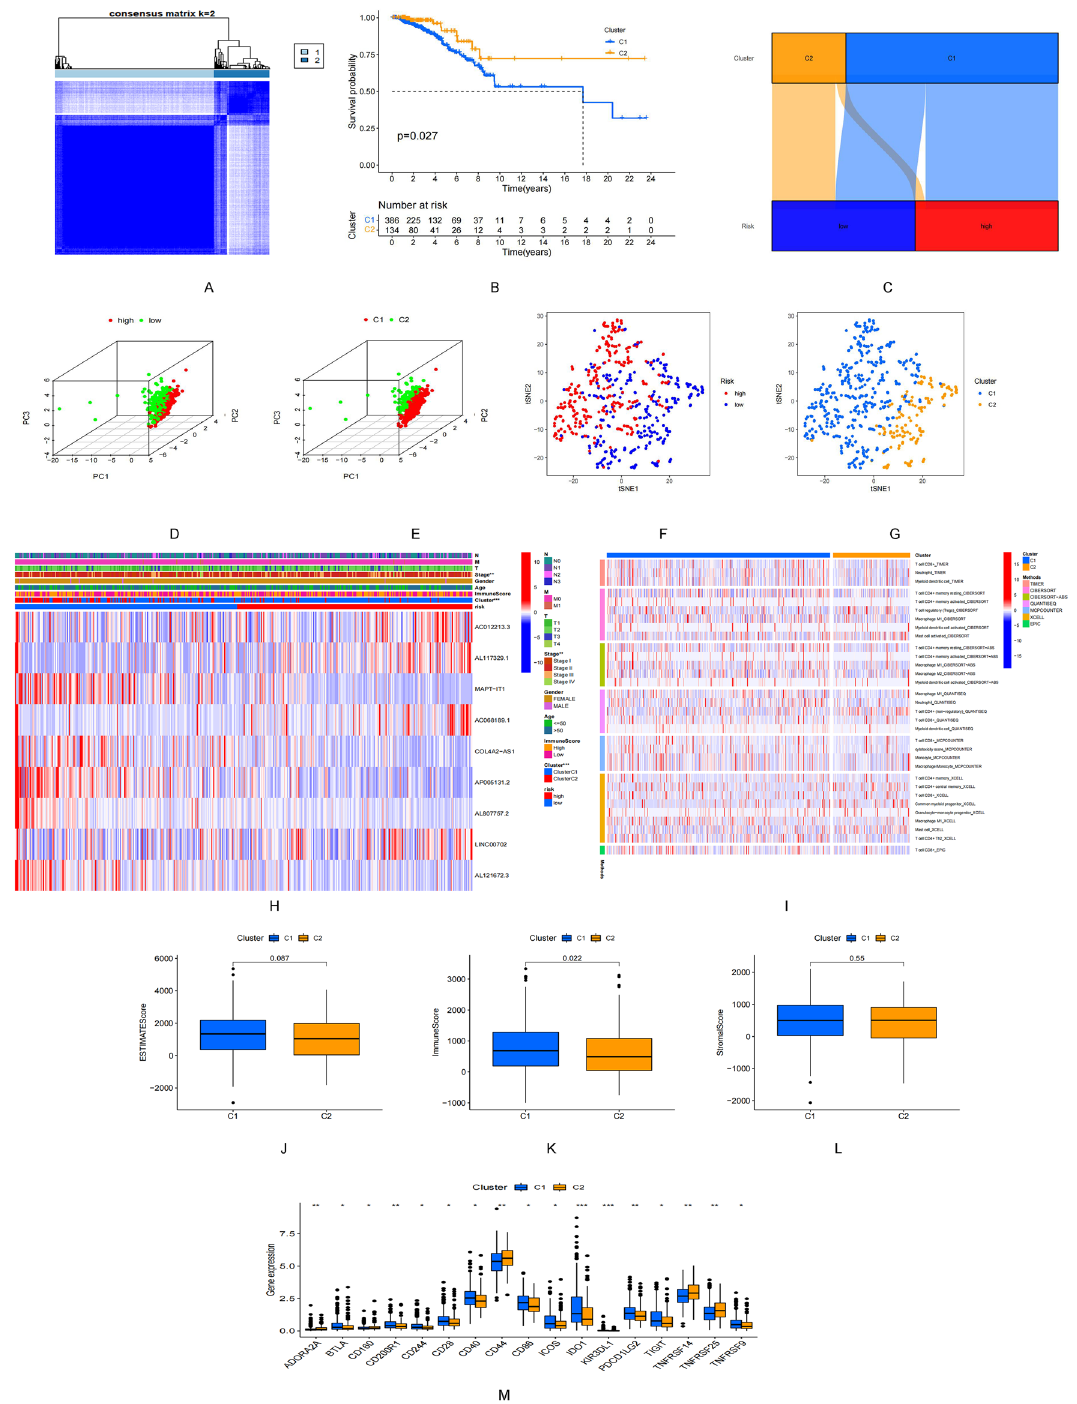
Figure 8. ARSP-lncRNAs subtypes and clinical characteristics. ( A ) Consensus matrix heat map defining the three clusters (k = 2). ( B ) Kaplan–Meier survival curves for the three subtypes. ( C ) Sankey diagram of three subtypes and high and low risk group. ( D , E ) PCA differentiation between high- and low-risk groups and three subtypes. ( F , G ) tSNE differentiation between high- and low-risk groups and three subtypes. ( H ) Differences in expression of ARSP-lncRNAs between the three subtypes, high- and low-risk and clinicopathological features. ( I ) Heat map of immune cell infiltration in the three subtypes. ( G – L ) Correlation of different subtypes with ESTIMATE score, Immune score and Stromal score. ( M ) Differences in expression of immune blocking sites in different